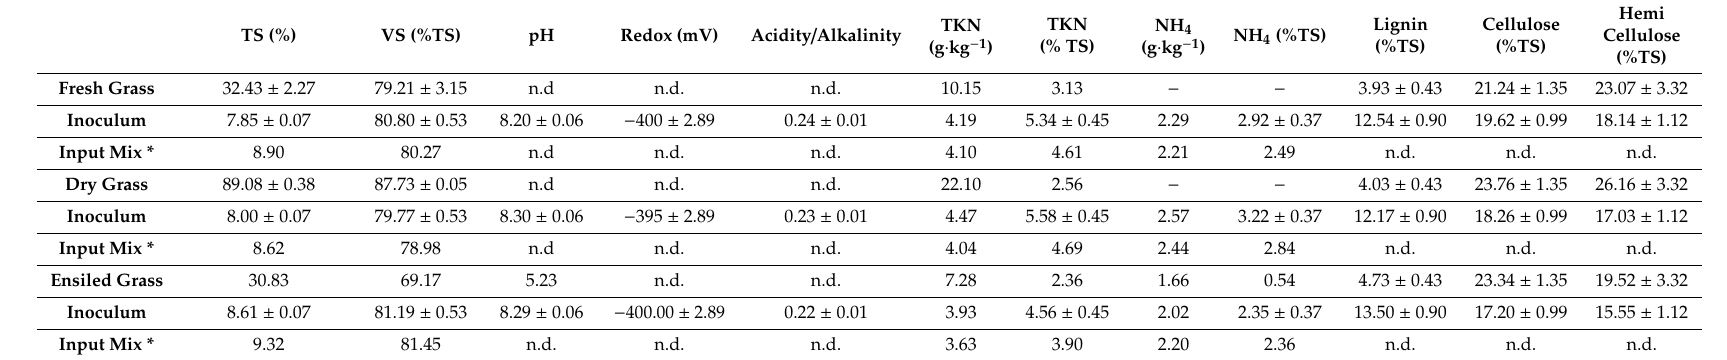
Table 1. Characteristics of the inoculum of fresh, dry and ensiled grass (n.d. indicates not determined).